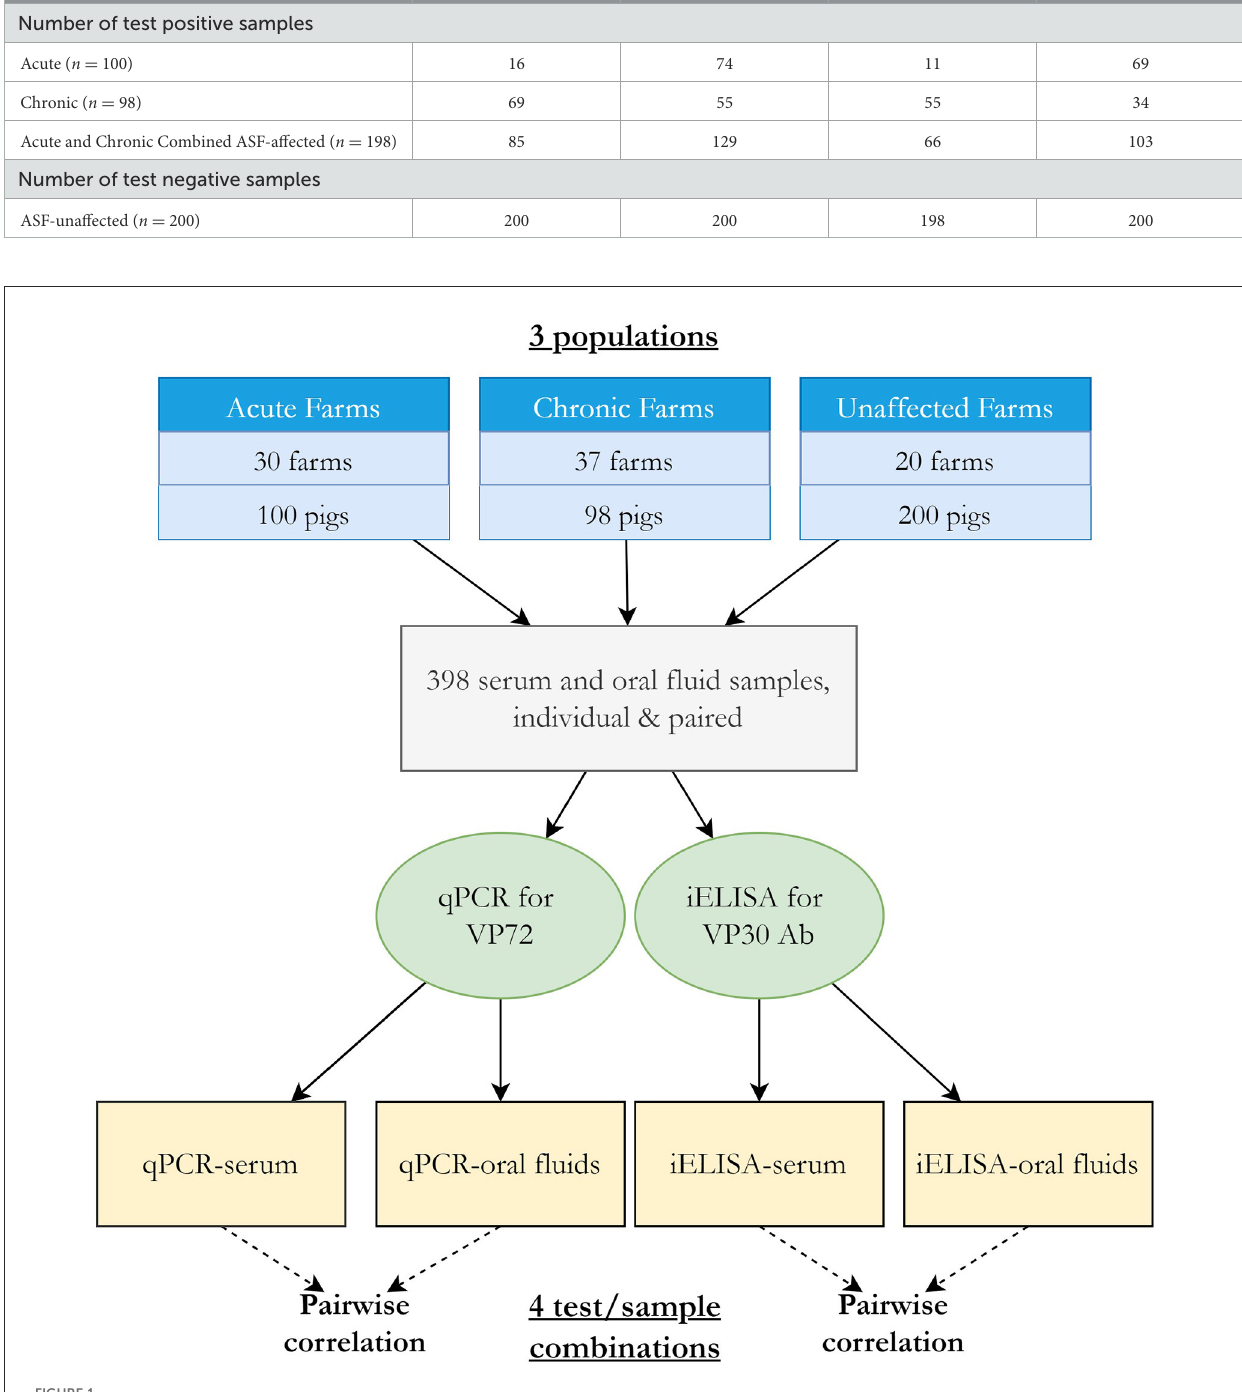
FIGURE1 Overview of BLCA study design and model.